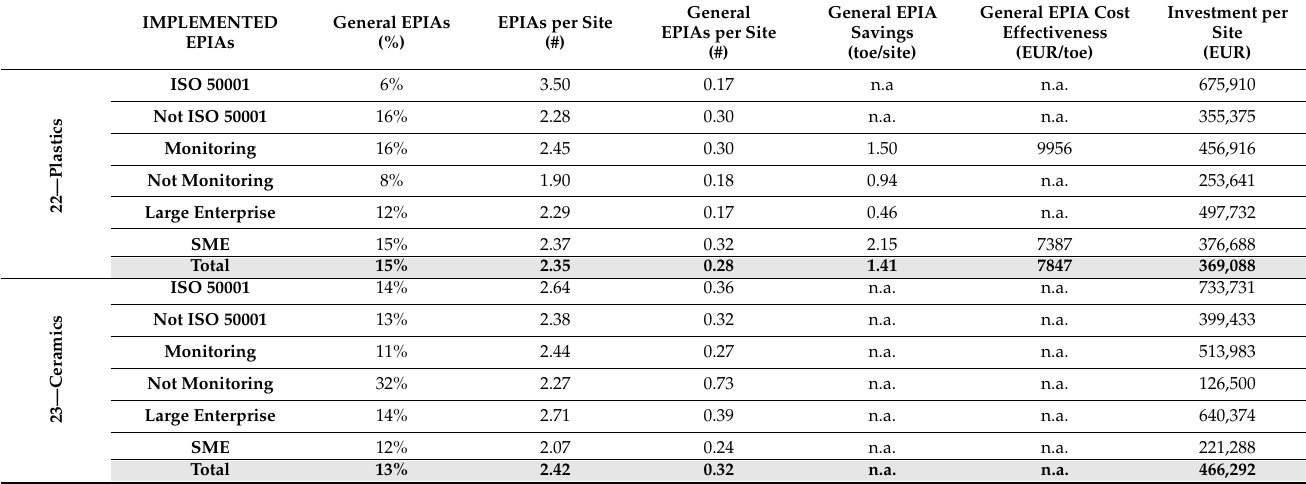
Table 1. Plastic and ceramic sector implemented EPIAs.